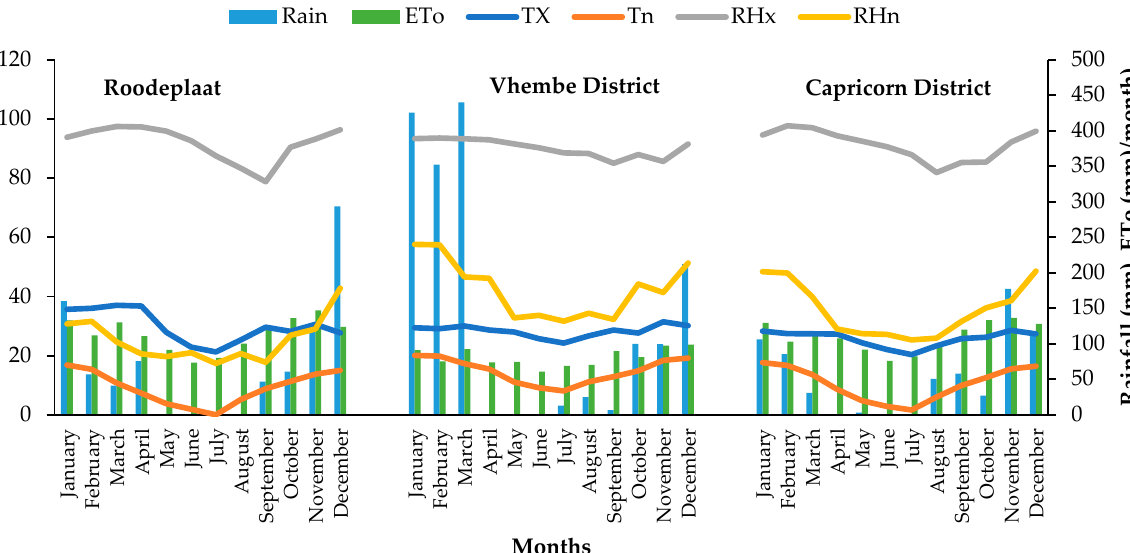
Figure 3. Weather conditions of Moringa oleifera plantations in three agro-ecological zones in South Africa (Roodeplaat, Vhembe District, and Capricorn District) from January to December 2020. Tx = maximum temperature (°C), Tn = minimum temperature (°C), RHx = maximum relative humidity, RHn = minimum relative humidity, ETo = reference evapotranspiration.